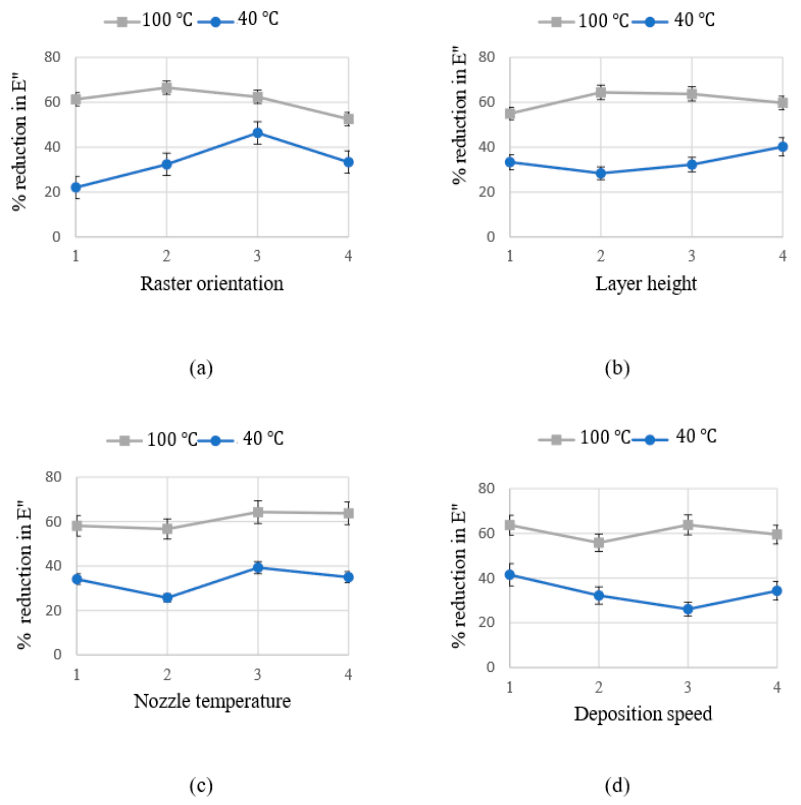
Figure 9. Percentage of reduction in loss modulus as a function of FDM process parameters: ( a ) Raster orientation; ( b ) Layer height; ( c ) Nozzle temperature; ( d ) Deposition speed. The blue and the grey lines represent the average reduction in the loss modulus at 40 ◦ C and 100 ◦ C respectively.